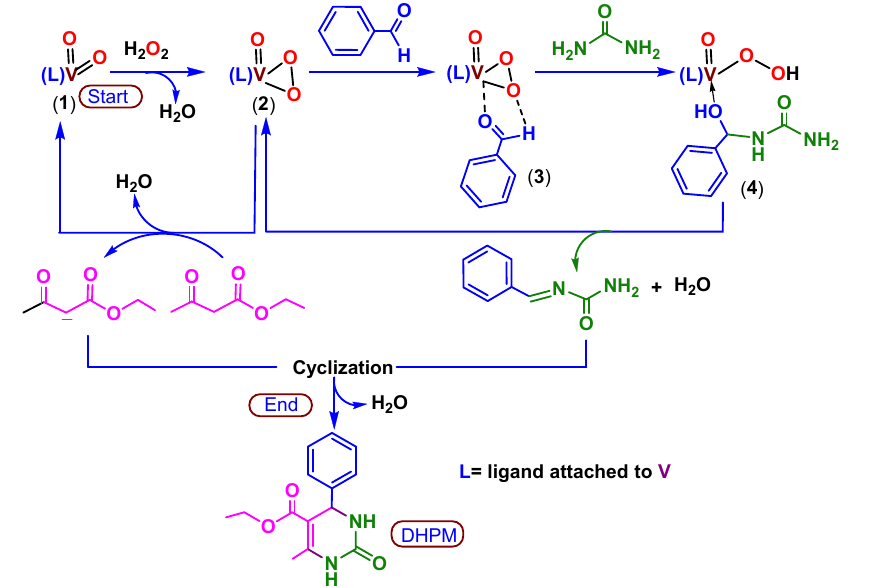
Scheme 3. Possible reaction mechanism for the three-component Biginelli reaction for the synthesis of 3,4-dihydropyrimidin-2-(1 H